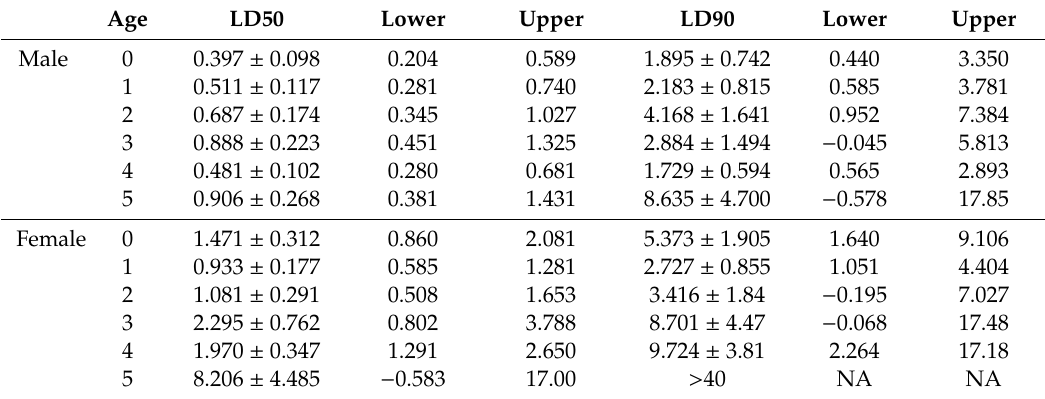
Table 5. Estimated lethal-sublethal dose (L-SD) (%ACI) to achieve 50 and 90% pupal death / eclosed to an adult with a deformity in C. fumiferana pupae on which tebufenozide had been topically applied.